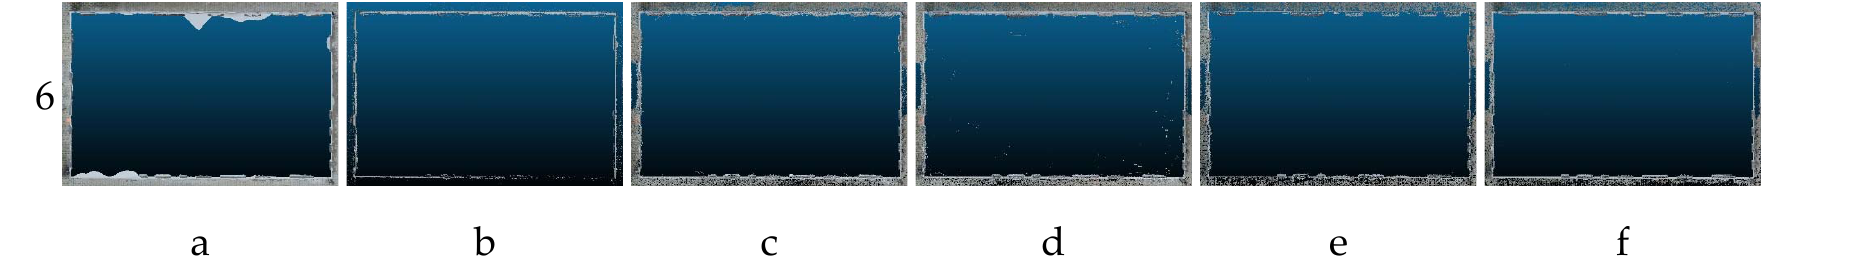
Figure A1. Comparison of the dense point clouds generated in used software: ( a ) ContextCapture; ( b ) GRAPHOS; ( c ) Metashape; ( d ) PhotoScan; ( e ) Pix4DMapper; ( f ) RealityCapture.